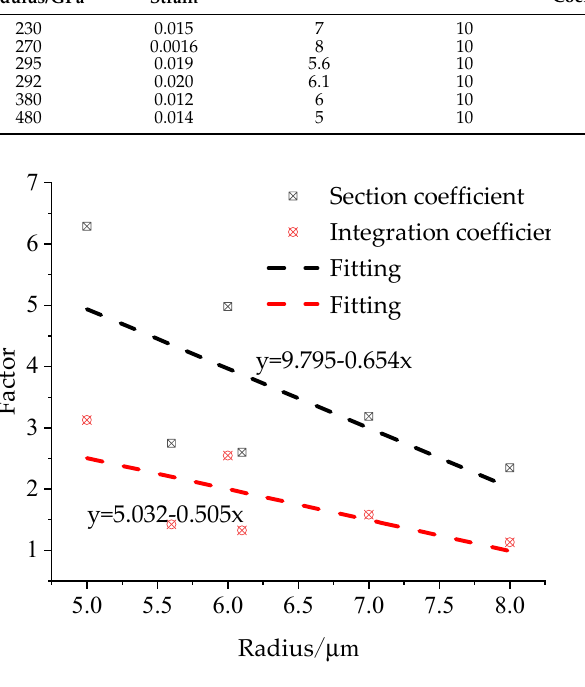
Figure 5. Relationship between fibre coefficient and radius. The relationship between the radius and length of different fibres can be obtained by substituting the cross-section coefficient and integral constant into Equation (20). The fibre with a length of 20 mm is taken as an example, in order to analyse the relationship between length and radius, as shown in Figure 6. Figure 6 indicates that the radius changes exponentially, and the change is fairly small when the fibre length changes from 0 mm to 20 mm. The radius changes slightly, and an extreme value is observed, when the fibre length increases to a certain extent. Some differences are found amongst fibres of different types with different properties, but the index variation trend is consistent.